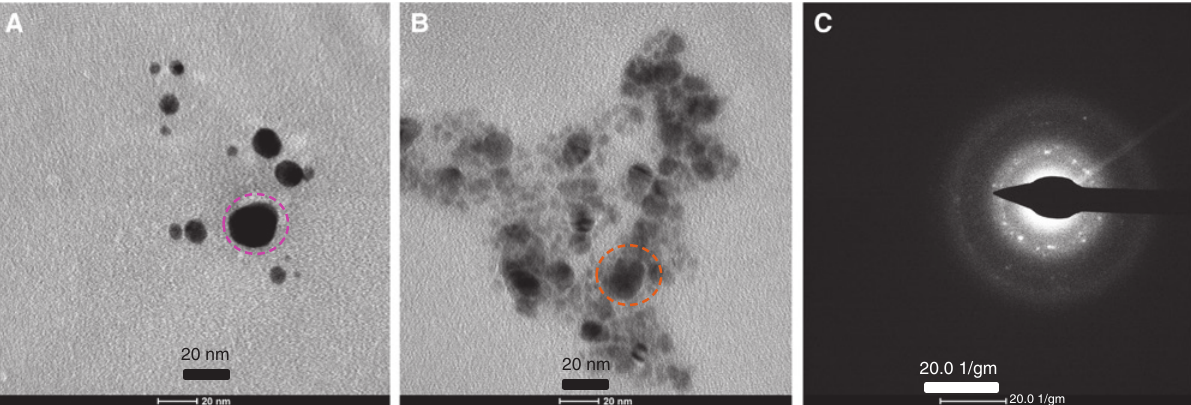
Figure 5: Transmission electron microscopy (TEM) images of silver nanoparticles (AgNps) derived from a Shora fruit extract at pH 11 (A) and influence of sunlight (B). Selected area electron diffraction (SAED) pattern (C) of AgNps synthesized from Shora fruit extract and sunlight.